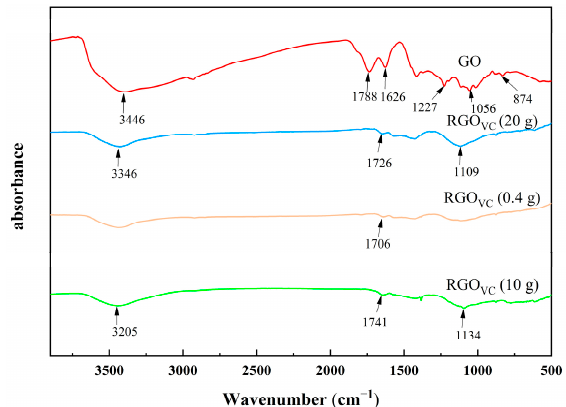
Figure 4. FTIR of RGO with different Vc dosages.